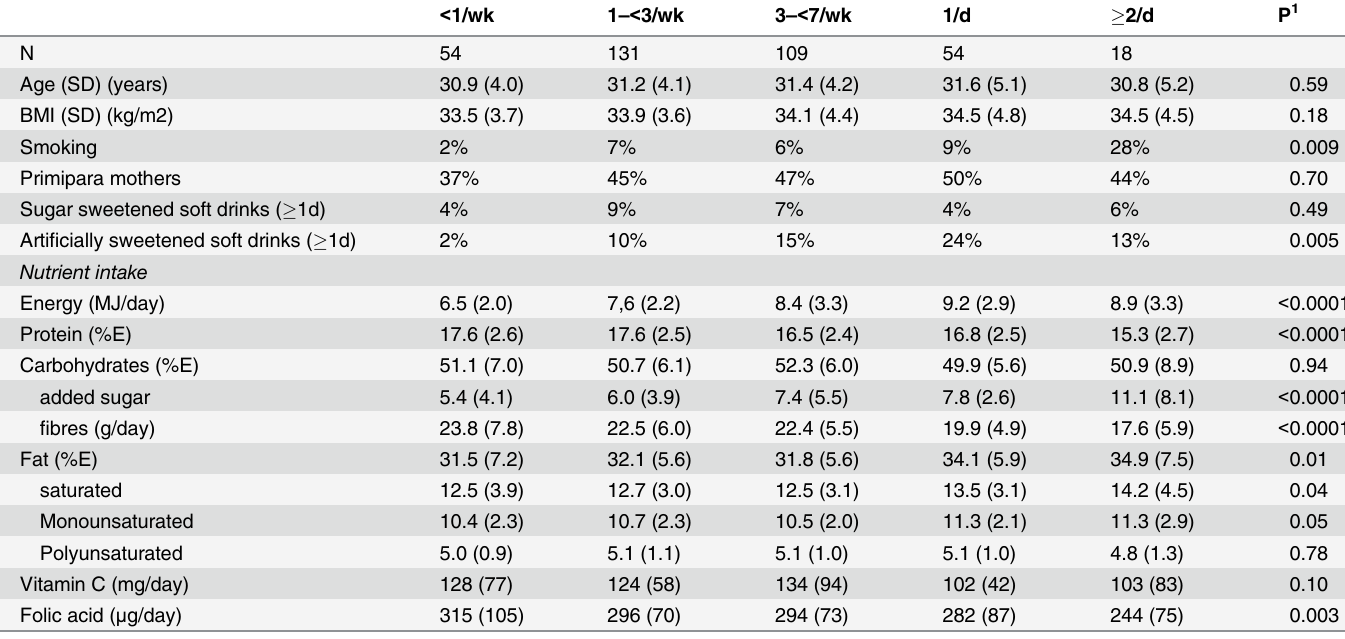
Table 6. Characteristics of study participants and mean macronutrient intake across categories of self-reported consumption of sweets at base- line (n =